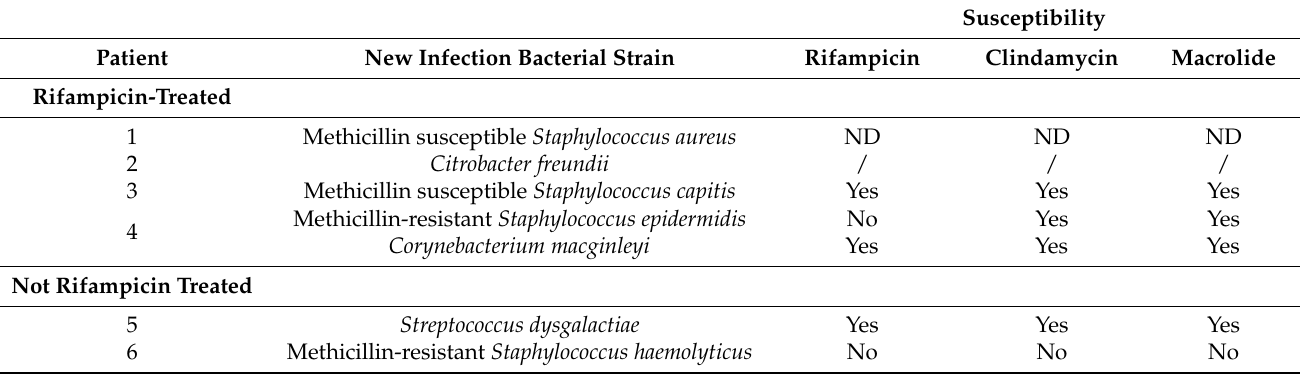
Table 4. Rifampicin, clindamycin and macrolide susceptibilities of bacterial strains isolated from new infections.